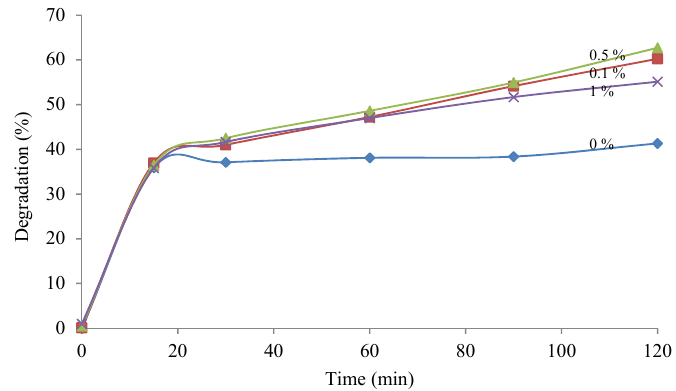
Fig. 5. Photocatalytic activity of Fe doped TiO Figure 5. Photocatalytic activity of Fe doped TiO 2 nanoparticles